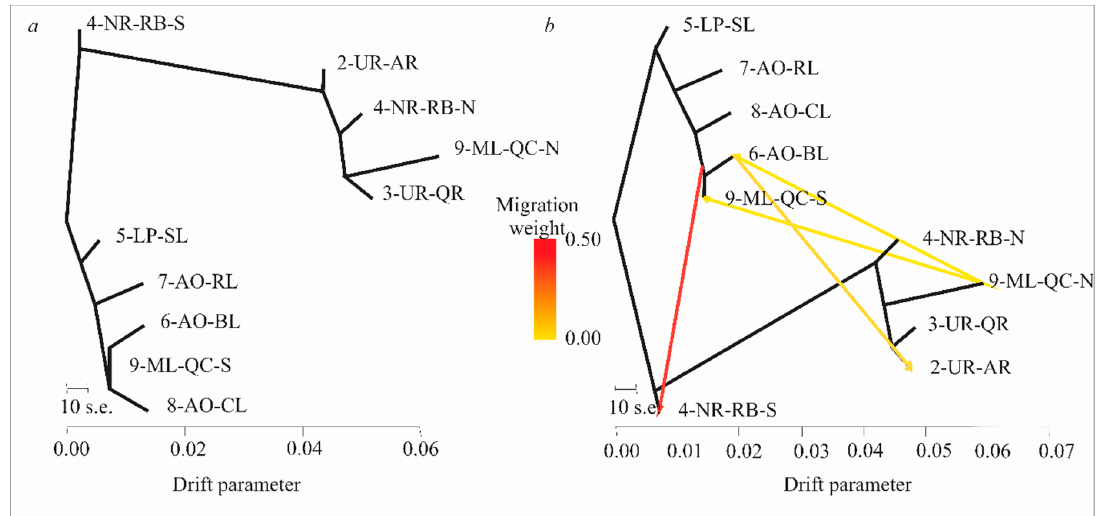
Figure 6. Population trees inferred by TREEMIX of eight locality samples in Rhamdia quelen ( a ) without or ( b ) with four significant migration events ( p -value < 0.005). Color of admixture arrows according to migration weight.